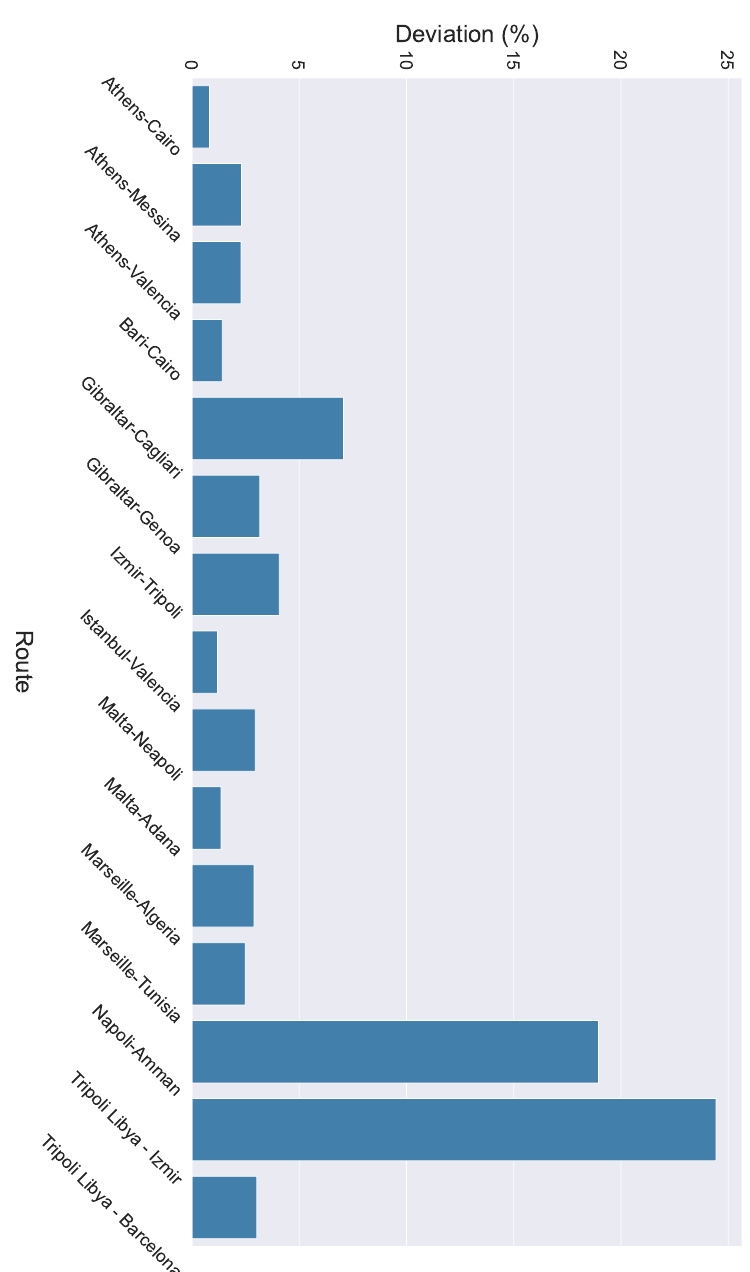
Figure 9. Based on the results, the maximum deviation reached 24% and the minimum deviation was approximately 0.5%.